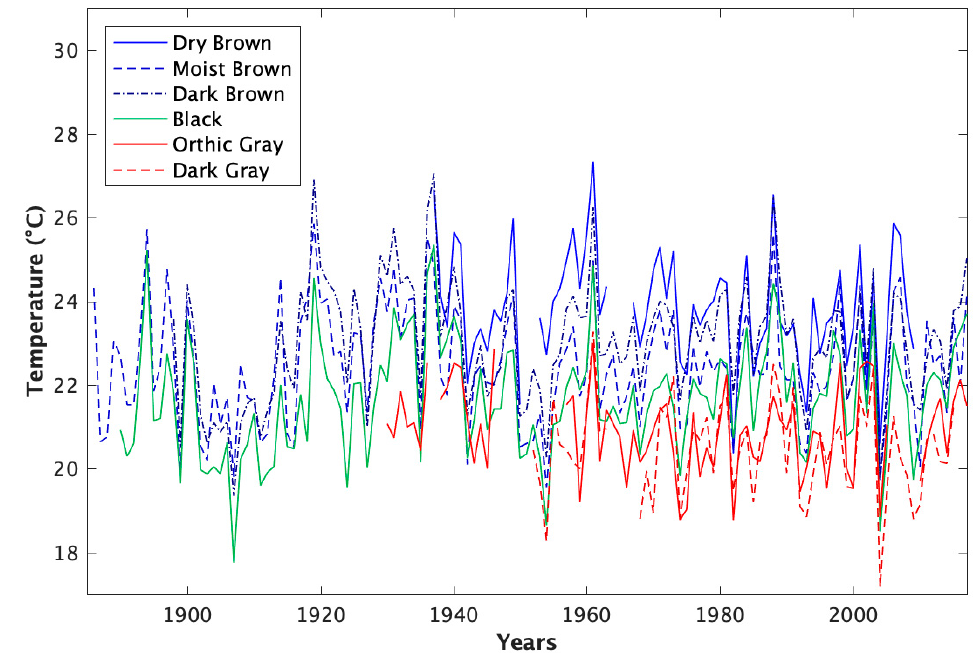
Figure 6. Growing season (May–August) maximum temperature (°C) (1885–2016) for all soil zones.